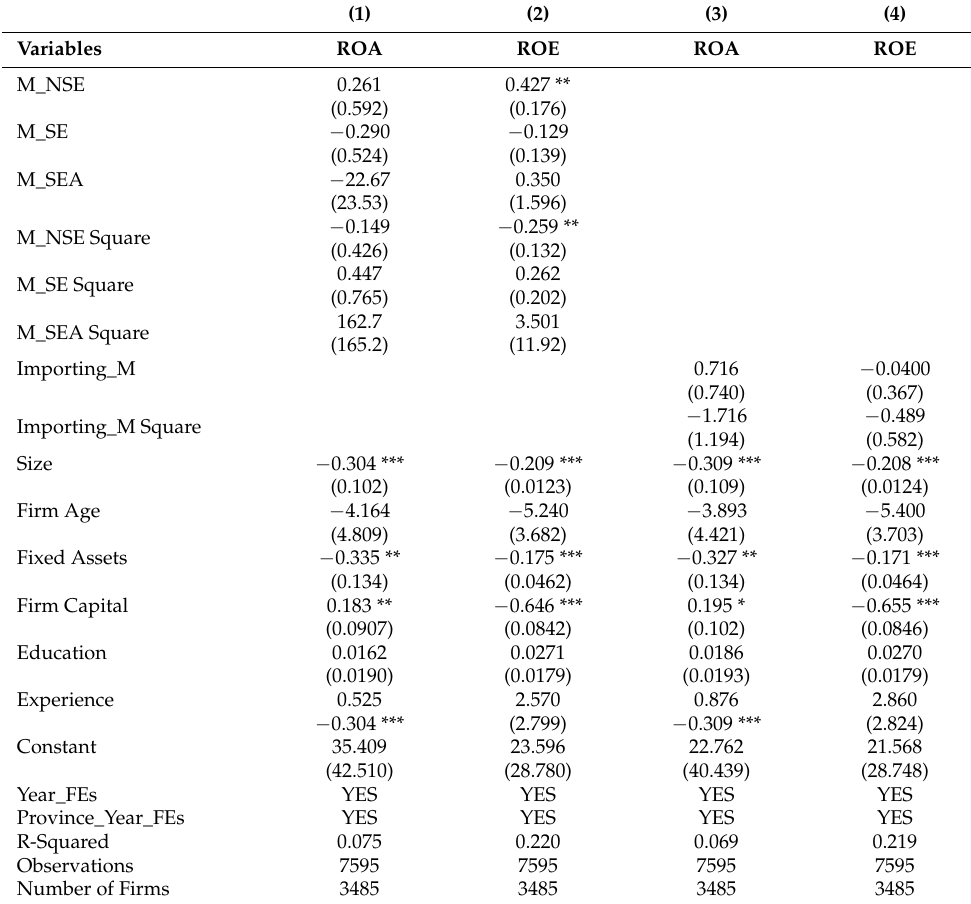
Table 6. Non-linear regression